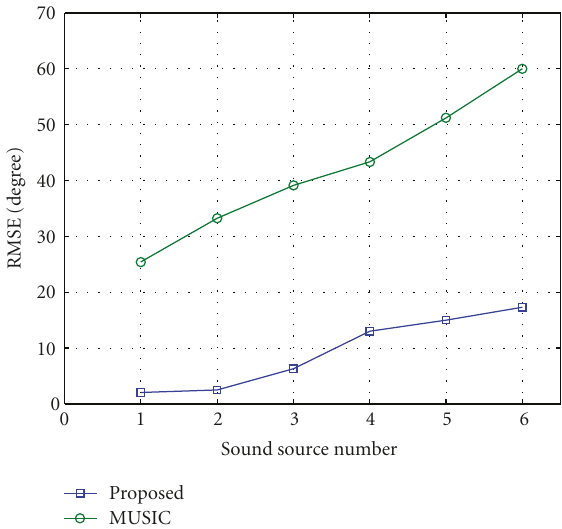
Figure 10: Sound source directions estimation result.